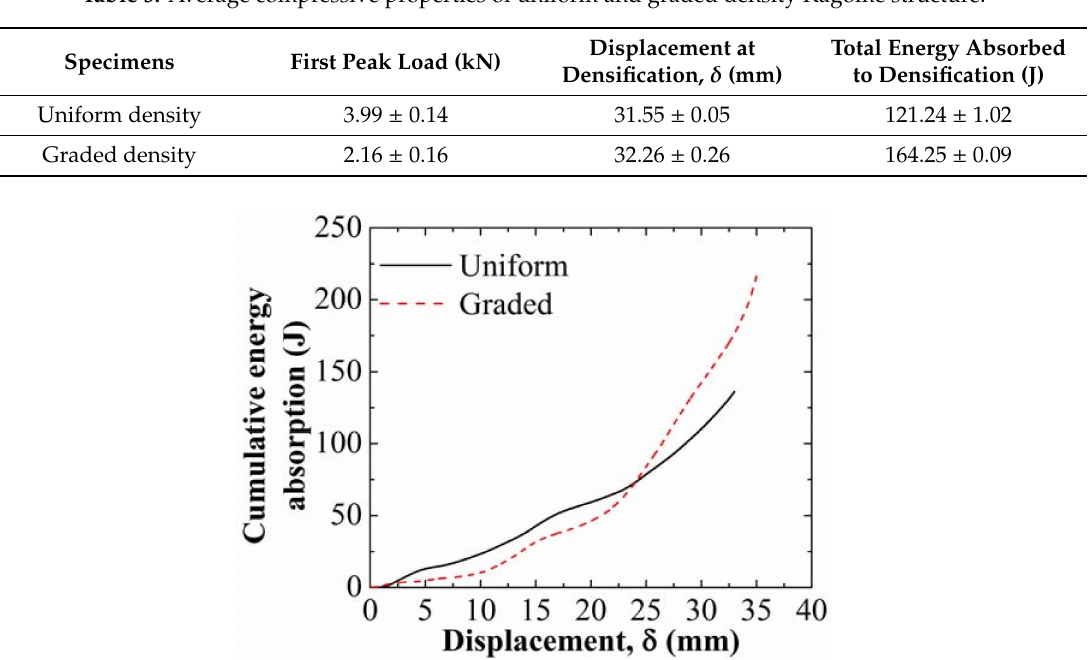
Table 5. Average compressive properties of uniform and graded density Kagome structure.